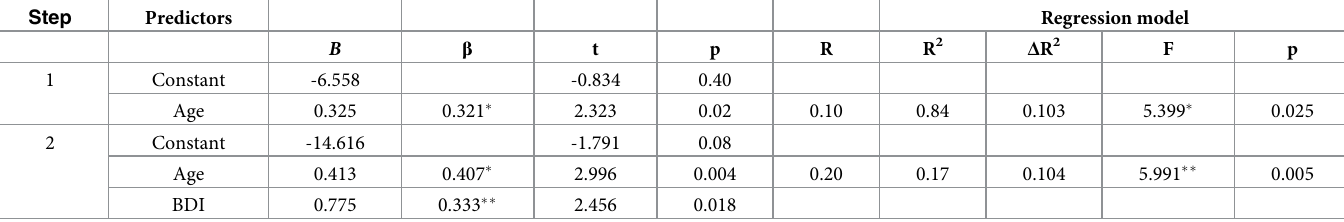
Table 3. Stepwise multiple linear regression analysis of difficulties in emotion regulation, depression, anxiety, age and the pain index scales on mistakes made in the attention